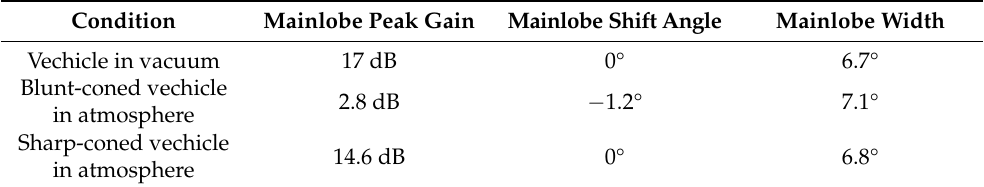
Table 1. The radiation parameters of the antenna in plasma for different vehicle shapes and in